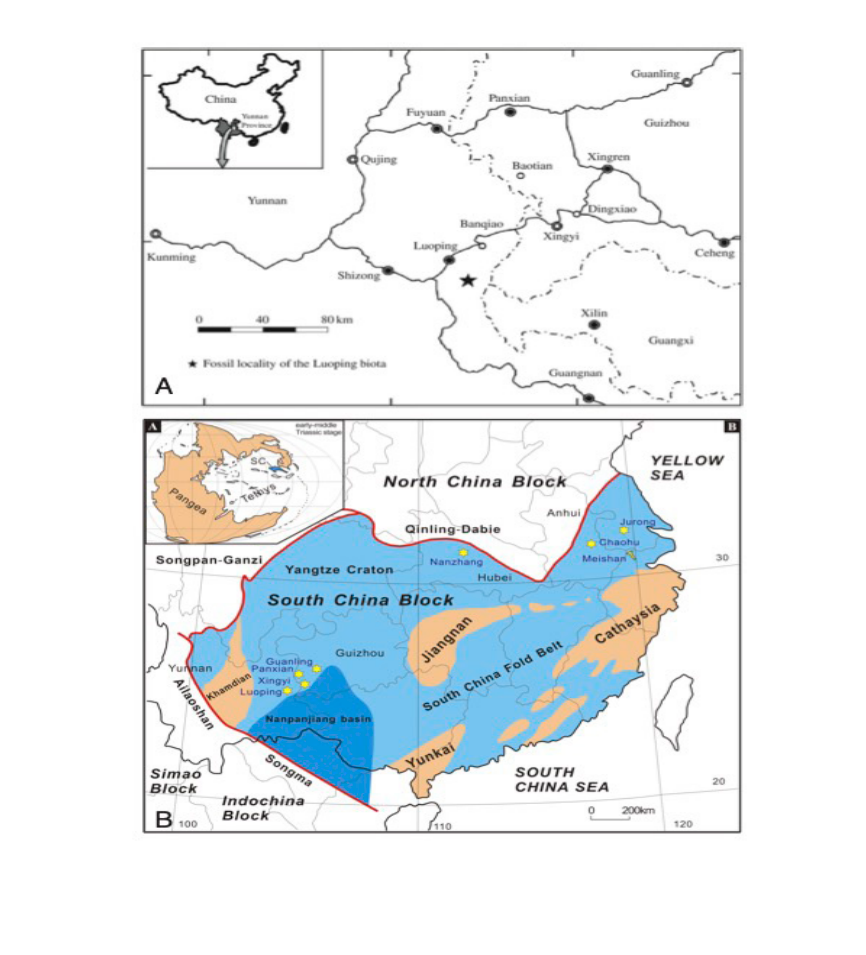
Figure 1. Topographic and geological maps. A) The location of Yunnan Province in China (top left) and the Luoping area, showing the site of the Luoping Geopark. B) Geology of South China in the Triassic, with general location of the South China Block in an Early–Late Triassic palaeogeographic map of the world (top left). Tectonic map illustrating major blocks of South China, interpreted suture zones and extent of the Nanpanjiang Basin and Yangtze Platform, with sites of named localities and biotas (yellow stars). ‘Old land’ is brown, shal- low seas pale blue, and deep marine basins dark blue. B is based on a map by Jinyuan Huang in Benton et al .